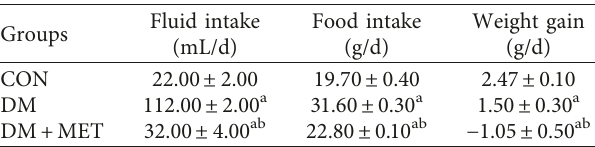
After STZ injection, metformin decreased food intake and body weight gain in rats. Data are mean ± SEM for twenty animals in each group. a p < 0 . 05 versus CON rats. b p < 0 . 05 vs. DM rats. CON rats: control rats group; DM rats: HFD/STZ induced diabetic rats group; DM+METF rats: HFD/STZ- induced diabetic rats supplemented with metformin